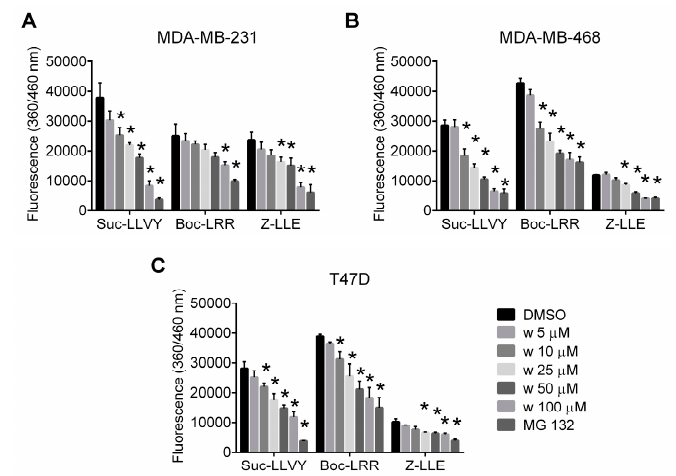
Figure 1. Wedelolactone inhibits chymotrypsin-like, trypsin-like and caspase-like activities in breast cancer cells. MDA-MB-231 ( A ); MDA-MB-468 ( B ); and T47D ( C ) cells were treated with various concentrations of wedelolactone (w) for 10 h. Proteasome activities were evaluated in cell extracts using the activity-specific fluorogenic substrates (Suc-LLVY-AMC for testing chymotrypsin-like, Z-LLE-AMC for caspase-like, and Boc-LRR-AMC for trypsin-like activities). Treatment with MG132 served as a positive control. The data represent the mean values from three independent experiments. Error bars indicate the SD. * indicates a significant ( p < 0.05) difference between wedelolactone-/MG132- and DMSO-treated cells.